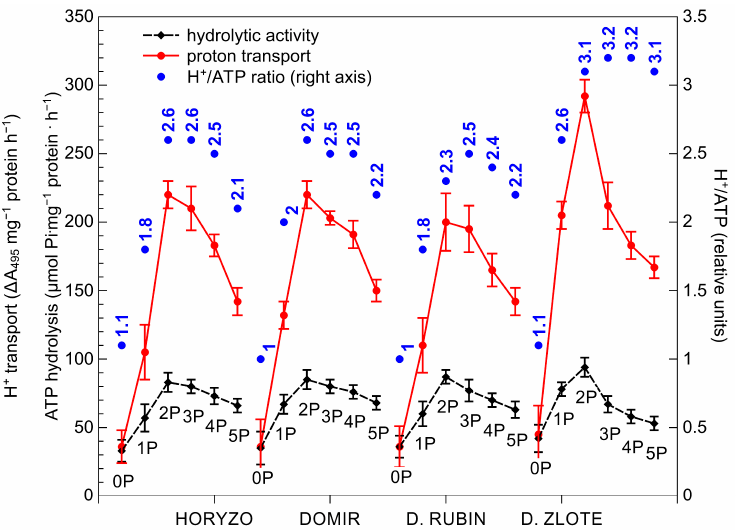
Figure 4. Effect of variable P supplementation on the H + -ATPase hydrolytic activity, the H + -ATPase- driven proton efflux, and the H + /ATP coupling ratio in roots of rye varieties grown on the post- flotation sediment. Plants were subjected to 0 (0P), 22 (1P), 44 (2P), 66 (3P), 88 (4P), and 110 (5P) mg P · kg − 1 . The plasma membrane vesicles were isolated from the root tissues, purified by two-phase partitioning, and the proton pump activities were determined spectrophotometrically. Data represent the means of n = 9 replications, and vertical bars represent 95% confidence interval after a post hoc Tukey HSD test (interaction P dose × variety), with the letters denoting homogeneous groups being omitted for a clear